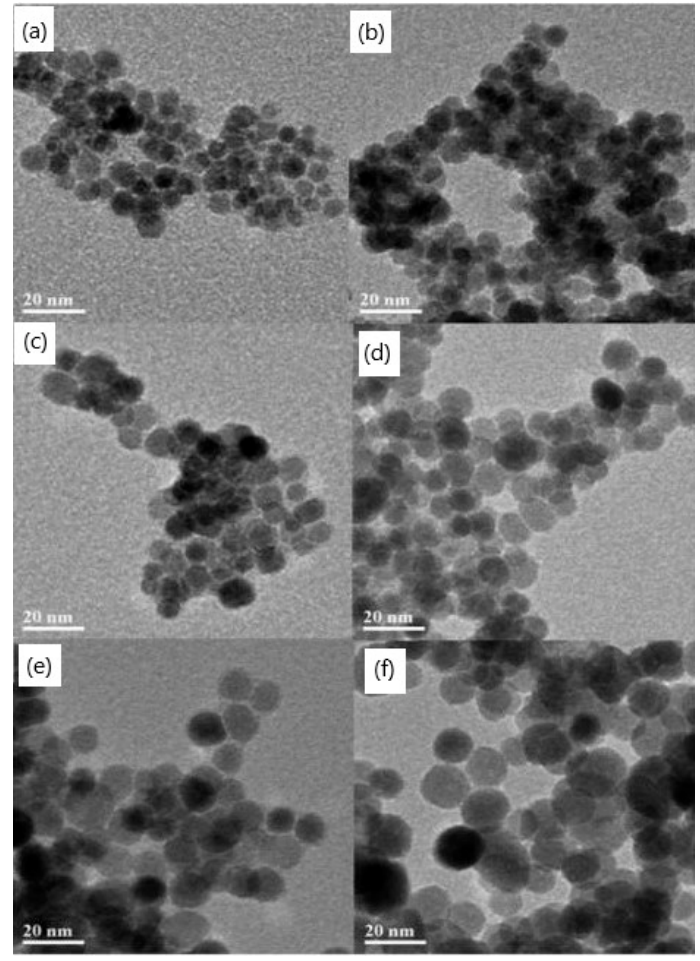
Figure 6. TEM images of iron oxide nanoparticles synthesized using different reaction times in tri(ethylene glycol): ( a ) 1 h, ( b ) 2 h, ( c ) 4 h, ( d ) 8 h, ( e ) 12 h, and ( f ) 24 h (adapted from [63] with permission from the Royal Society of Chemistry).